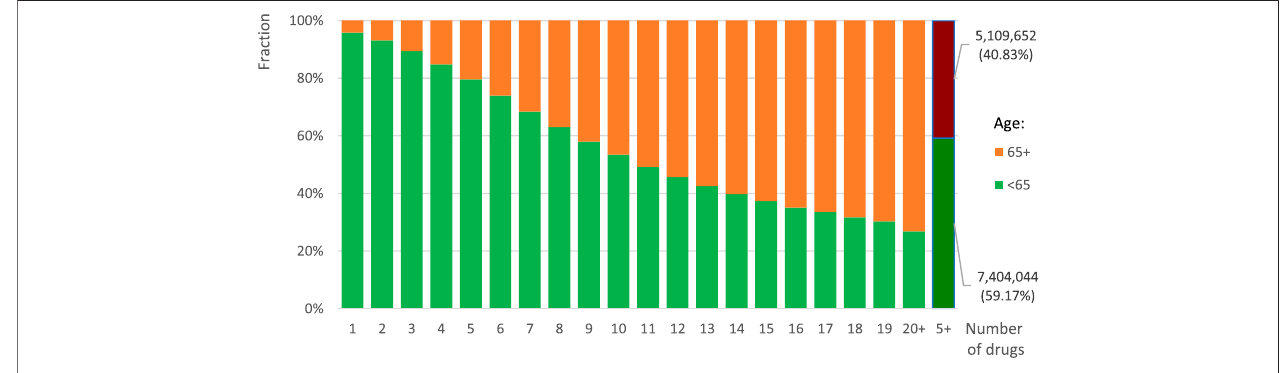
FIGURE 3 | Age structure of individuals dispensed various number of drugs holding various active substances according toprescriptions for both reimbursed and non-reimbursed drugs in 2019 in Poland.